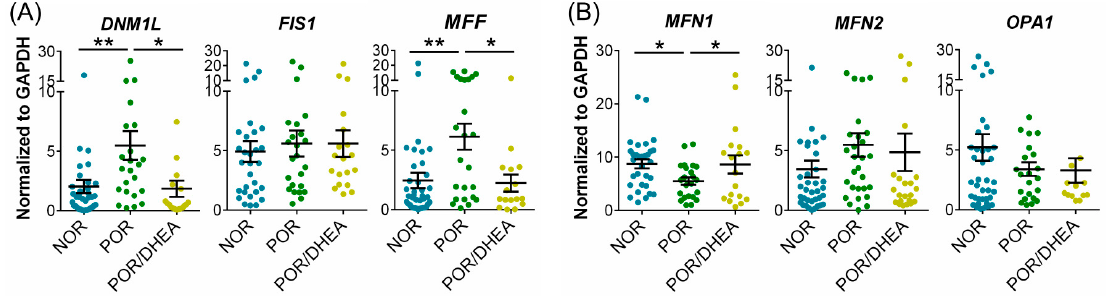
Figure 5. DHEA supplementation regulated mitochondrial dynamics of cumulus cells (CCs) from PORs. ( A , B ) Quantitative real-time polymerase chain reaction analysis for relative mRNA levels of major mitochondrial dynamics genes of CCs among the normal ovarian responder (NOR) ( n = 28), poor ovarian responder (POR) ( n = 19) and POR/DHEA groups ( n = 19). * p < 0.05, ** p < 0.01.